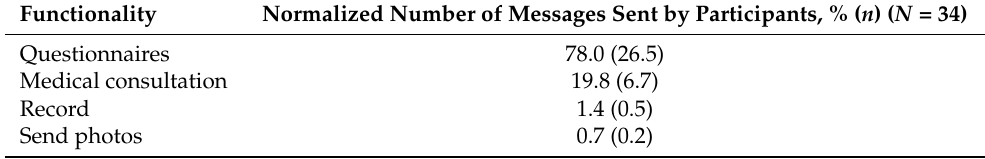
Table 4. Participants’ usage analysis of the